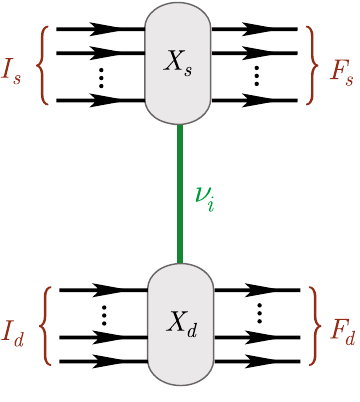
Fig. 1 A generic macrodiagram with virtual neutrino exchange. I s and I d denote the sets of initial wave-packet states in the source and detector vertices X s and X d , respectively, F s and F d denote the sets of the final states. The vertices X s and X d , which may include arbitrary inner lines and loops, are assumed to be macroscopically separated in space and time. The inner line connecting X s and X d denotes the causal Green’s function for the neutrino ν i with definite mass m